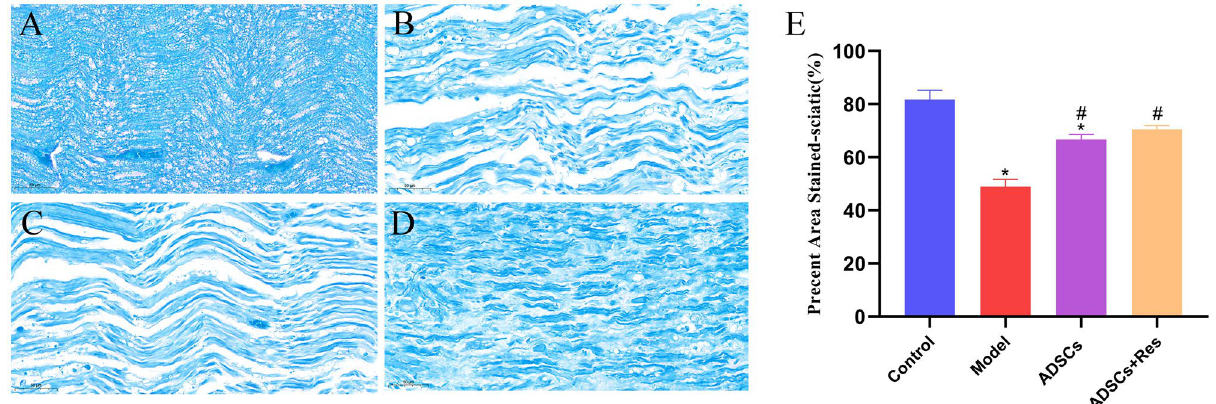
Figure 7. Effects of ADSCs pretreated with resveratrol on myelin regeneration after sciatic nerve injury in rats. ( A ) Control group; ( B ) Model group; ( C ) ADSCs group; ( D ) ADSCs + Res group; ( E ) Percentage of the stained sciatic area. * P < 0.05 compared with the control group, n = 5; # P < 0.05 compared with model group, n = 5. Scale bar: 50